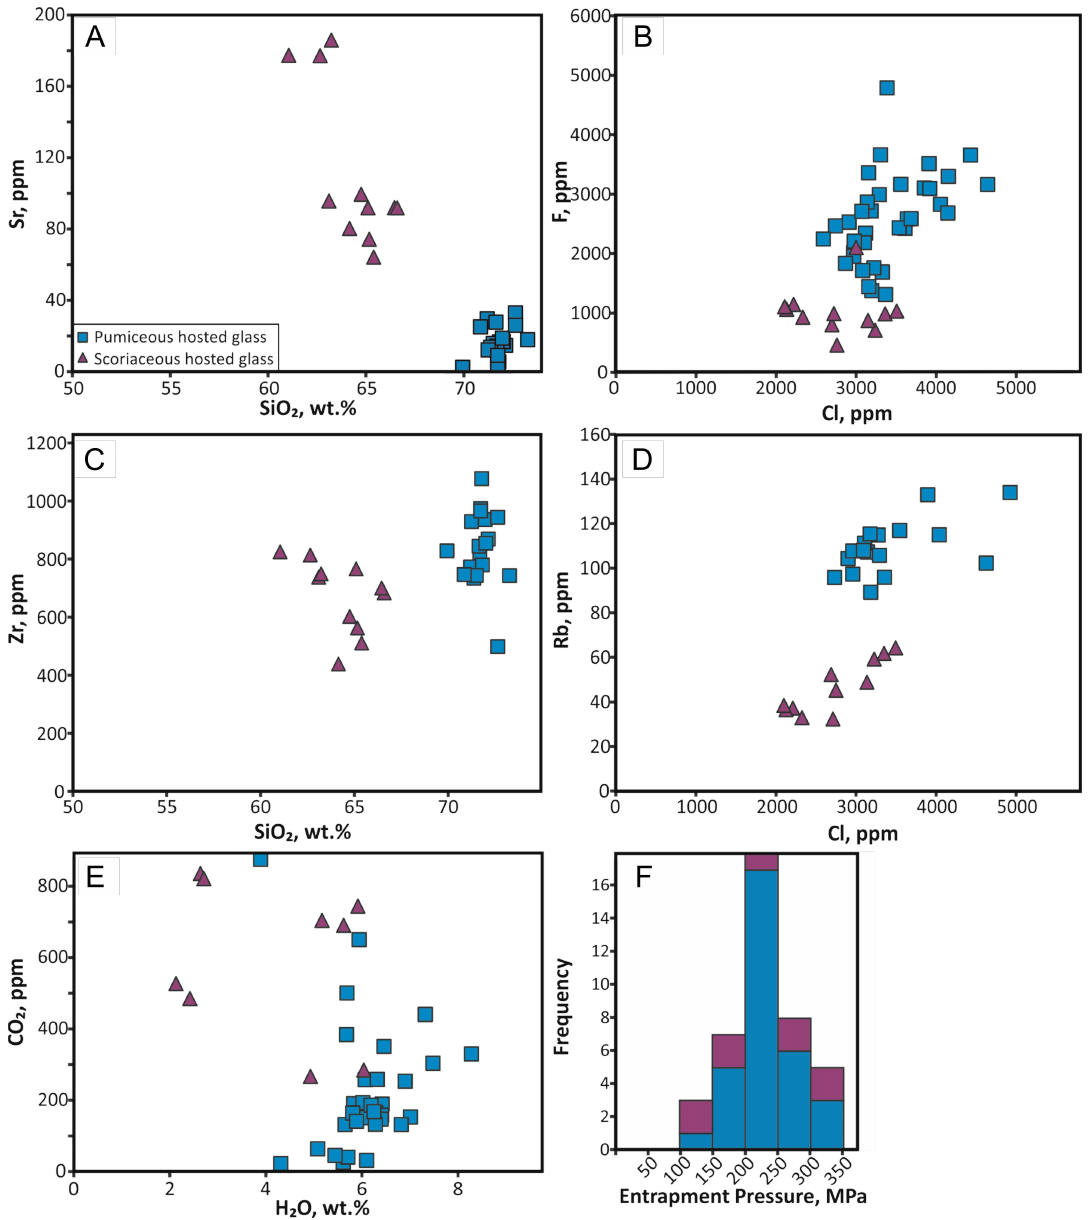
Figure 7: [A]–[E] Compositional variation in major, trace and volatile elements in melt inclusions from the min- gled fall deposit; [F] Histogram of modelled entrapment pressures in MPa from all melt inclusions, modelled using the MagmaSat application of Ghiorso and Gualda